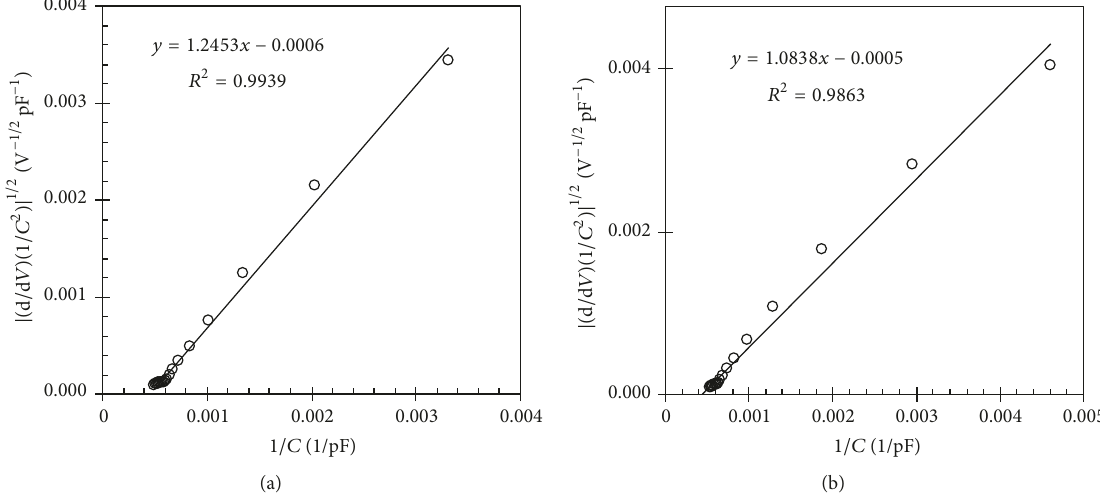
Figure 14: d (1/𝐶 2 )/ d 𝑉 versus 1/𝐶 plot for 100kHz for 𝐶